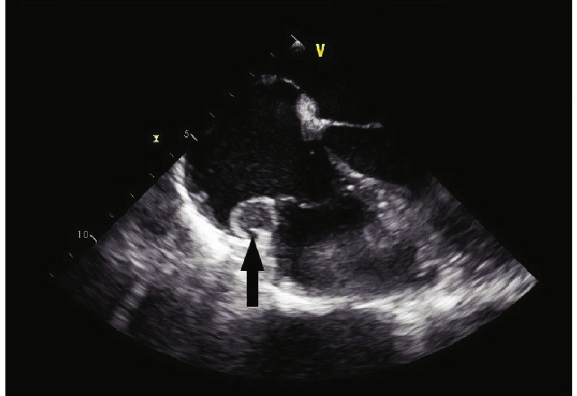
Figure 1: TEE horizontal view: right atrial mass (black arrow) in the area adjacent to the tricuspid valve. No visual obstruction of fl ow was identi fi ed on Doppler.